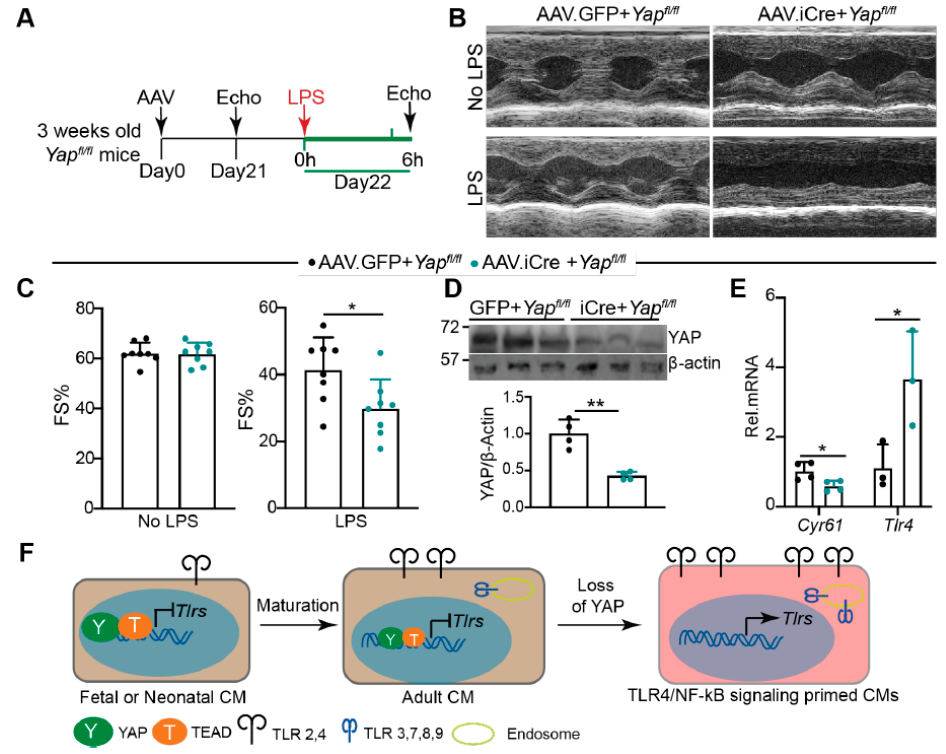
Figure 7. Knocking down YAP in CMs predisposes the heart to LPS stress. (A). Experimental de- sign. Indicated AAVs were retro-orbitally delivered into 3 weeks old Yap fl/fl mice. Twenty-one days later, echocardiography was performed to measure cardiac function. Twenty-two days after AAV delivery, 6 mg/kg LPS was intraperitoneally injected into AAV transduced mice. Echocardiography measurements were performed 6 h after LPS treatment. ( B ). Representative M mode cardiac echo- cardiograms before and after LPS treatment. ( C ). Fraction shortening before and after LPS treatment. AAV9.cTnT.GFP (AAV.GFP), n = 8; AAV9.cTnT.iCre (AAV.iCre), n = 8. ( D ). YAP Immunot Blot and densitometry quantification. YAP protein level was normalized to β -actin. n = 4 for each group. ( E ). qRT-PCR measurement. N = 3–4 for each group. Gene expression level was normalized to Gapdh . ( D , E ), 6 h after LPS treatment, hearts were collected for protein and RNA extraction. ( C – E ), student’s t test, *. p < 0.05, **, p < 0.01. ( F ). Schematic summary of the current study. During heart development, the expression of Tlr2 and Tlr4 and intracellular TLR genes increases with age. YAP/TEAD1 complex is a default repressor of TLR genes in intact hearts. Cardiomyocyte-specific YAP depletion unleashes the expression of TLR genes and primes the CMs for generating inflam- matory cytokine peptides. Brown color background in fetal/neonatal and adult CMs indicates a healthy status; pink color background in YAP depleted CMs indicates an innate immune signaling active status.